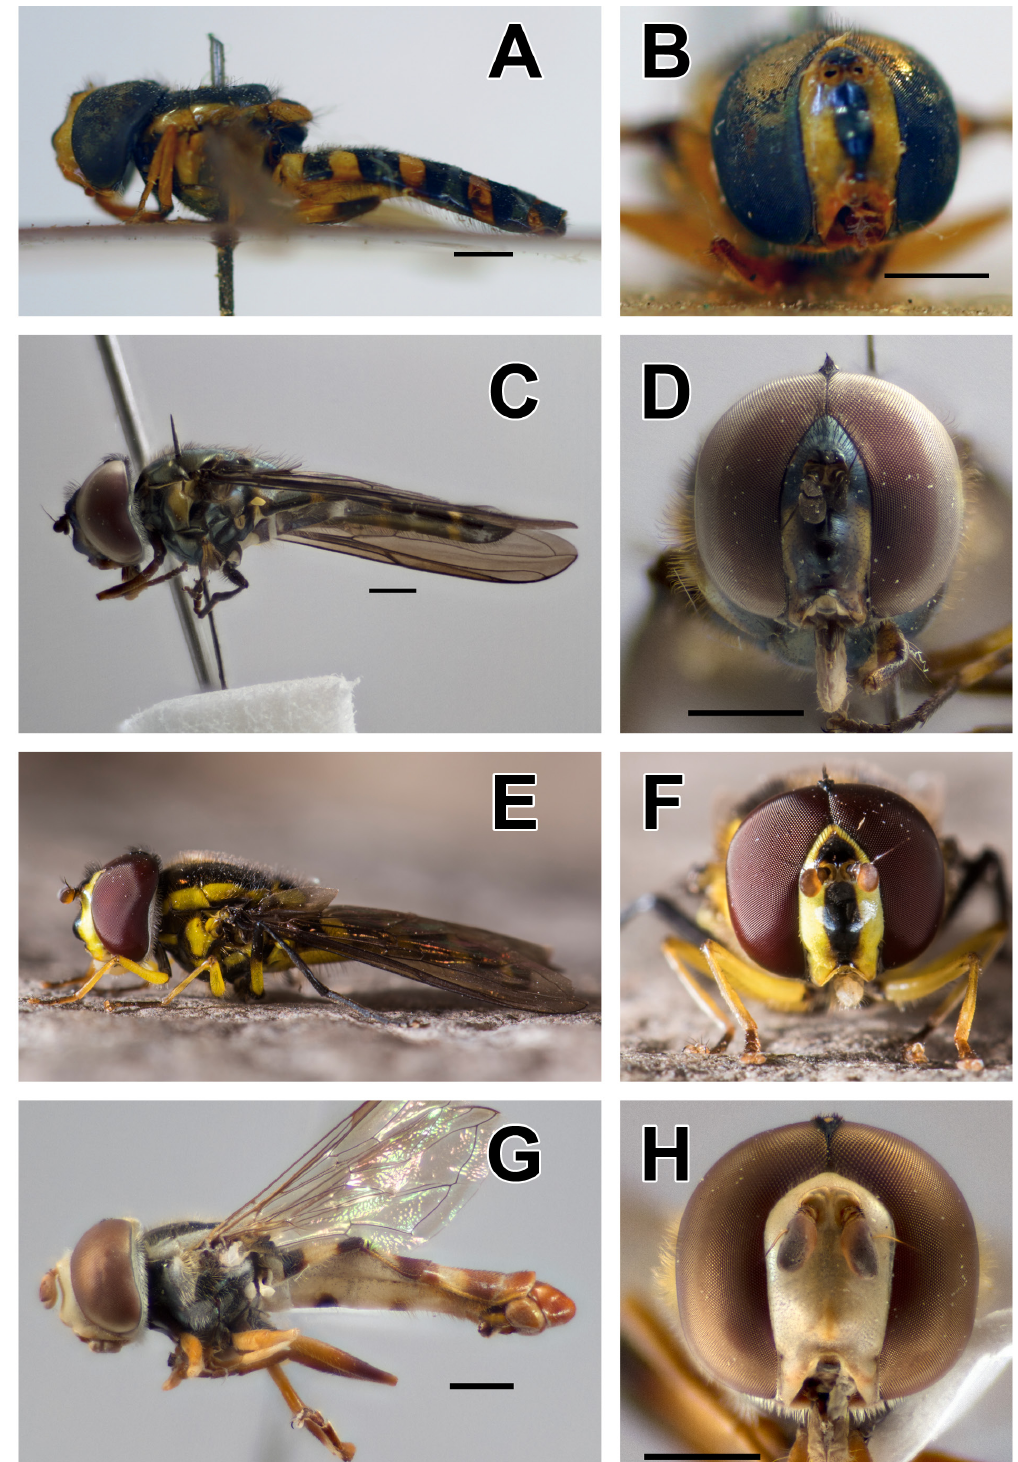
Fig. 3. A–B . Allograpta amphotera (Bezzi, 1928), holotype, ♂. A. Lateral view. B. Frontal view. C–D . Allograpta jacqui Mengual & Ramage sp. nov., holotype, ♂, (ZFMK-DIP-00026906). C. Lateral view. D. Frontal view. E–F . A. nigripilosa (Hull, 1944), ♂ (photographs by F. Jacq). E. Lateral view. F. Frontal view. G–H . Ischiodon scutellaris (Fabricius, 1805), ♂ (ZFMK-DIP-00019713). G. Lateral view. H. Frontal view. Scale bars = 1